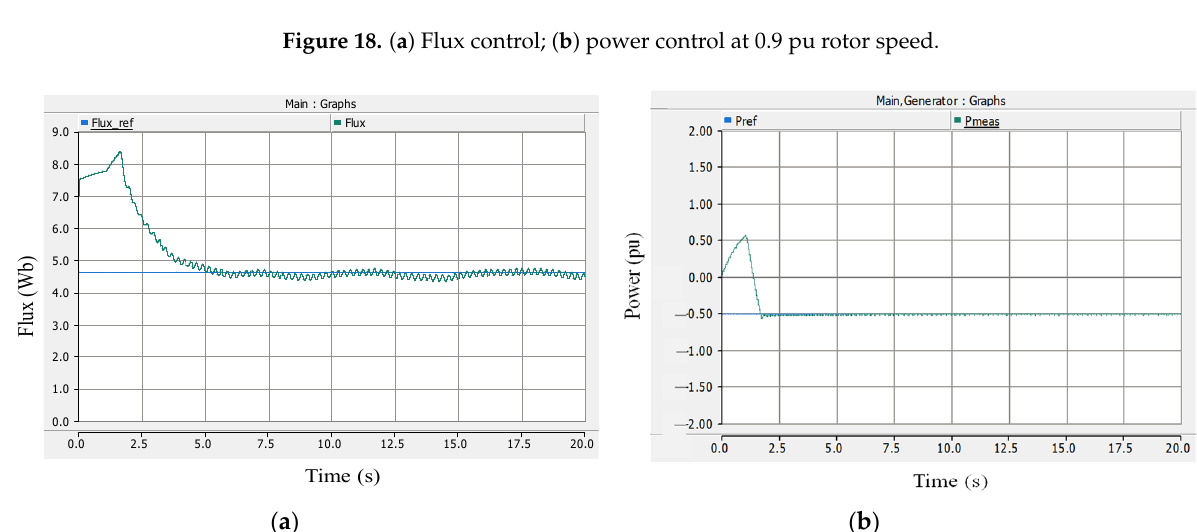
Figure 19. ( a ) Flux control; ( b ) power control at 0.8 pu rotor speed.